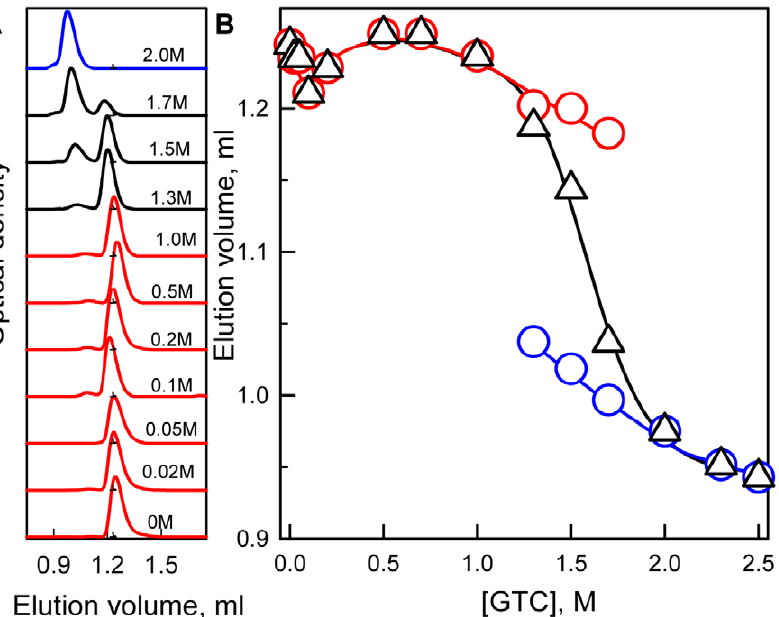
Figure 6. Changes of hydrodynamic dimensions of sfGFP induced by GTC. ( A ) Changes of elution profile of sfGFP at increasing denaturant concentration. Numerals at the curves specify applied denaturant concentration. ( B ) Changes of the position of elution peaks of compact and denatured molecules (red and blue circles, respectively) and the change of averaged elution volume of sfGFP (black triangles). The value of averaged elution volume ( , V . ) was calculated as V ~ f c V c z f d V d , were f c ( d ) is portion of compact (denatured) molecules and V c ( d ) is elution volume of molecules in these states. The value of f c ( d ) is estimated as f c ( d ) ~ S c ( d ) = ( S c z S d ) , were S c ( d ) represents the area under peak corresponding to compact (denatured) molecules.